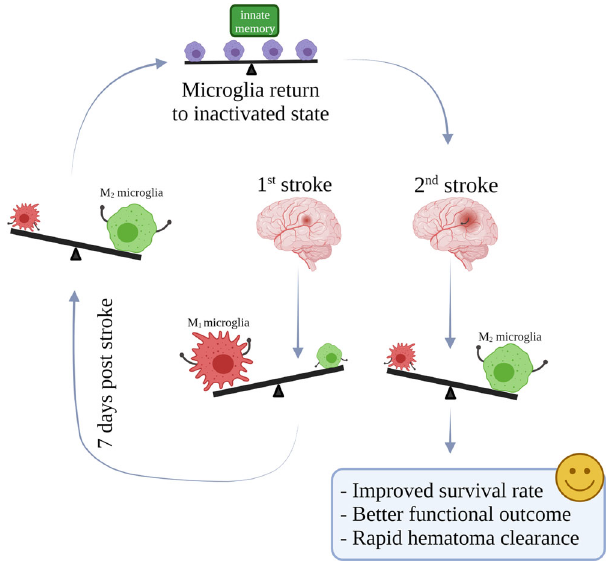
Fig. 7 Graphic summary. The fi rst hemorrhagic stroke initiated a cascade of in fl ammatory actions downstream that corresponds to what others have observed in the past: M1 microglia take dominance initially before gradually declining to give way to an M2 predominant pro fi le at day 7 post hemorrhagic stroke. Microglia then return to baseline levels. When a second hemorrhagic stroke was introduced, microglia no longer followed the former polarization pro fi le but rather assumed an M2 predominant phenotype at an early stage. The group of mice with a previous stroke demonstrated improved survival rates, better functional outcomes, and rapid lesion resolution, compared to mice that were only encountering a hemorrhagic stroke for the fi rst